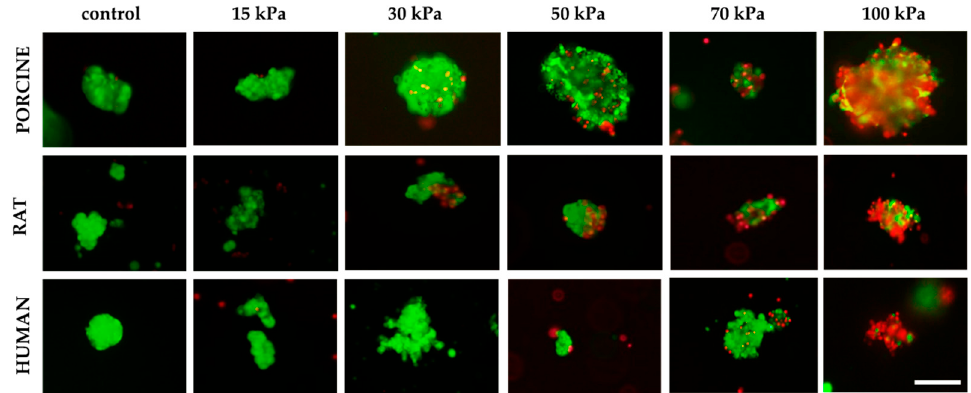
Figure 8. Influence of pressure on pancreatic islet viability. Islets were stained by FDA/PI. Green fluorescence means live cells and the red fluorescence mean dead cells. Inner diameter of the nozzle was 0.6 mm. The islets shown are 50–200 µ m in size for porcine and human material. By contrast, the size of the rat islets was between 50–100 µ m; scale 100 µ m.